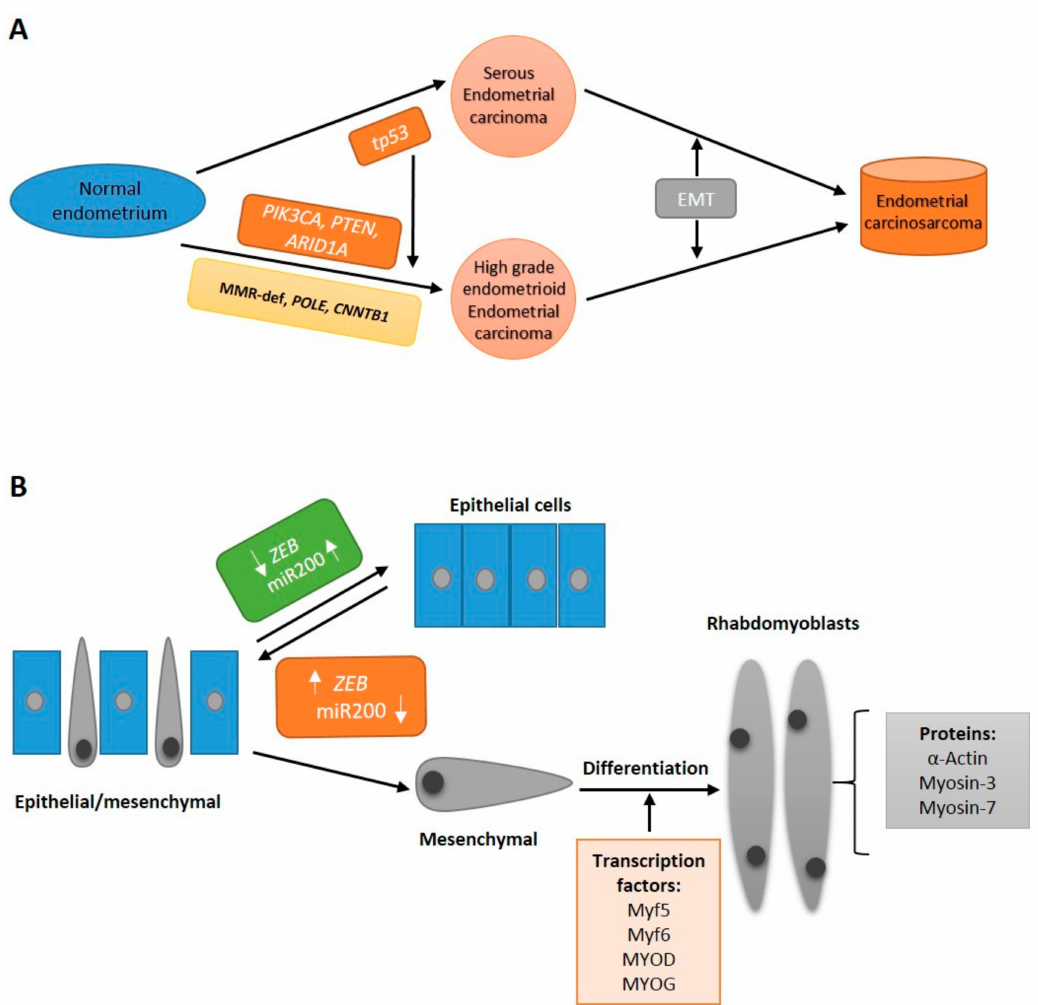
Figure 5. A proposed model of development of endometrial carcinosarcoma. ( A ) Evolution of both endometrioid and serous carcinomas to endometrial carcinosarcoma after eliciting a stable epithelial-to-mesenchymal transition (EMT) program. Transformation of normal endometrium to serous endometrial carcinoma is triggered by mutation in TP53. Endometrioid carcinomas with mutations in genes of the phosphatidylinositol 3-kinase (PIK3) pathway or ARID1A are more prone to acquire TP53 mutations than those with mismatch repair deficiency or mutations in POLE and CTNNB1 . ( B ) Endometrial carcinosarcomas are composed by a mixed population of cells representing diverse EMT states. The relative expression of some factors, such as miR-200 or ZEBs, dictate the specific cell state: epithelial, hybrid, or mesenchymal (adapted from Ref.